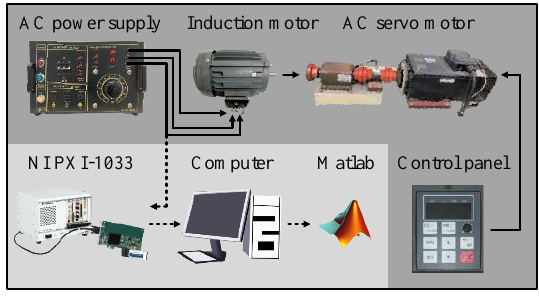
Figure 12. Equipment layout to capture the current signal of induction motor.